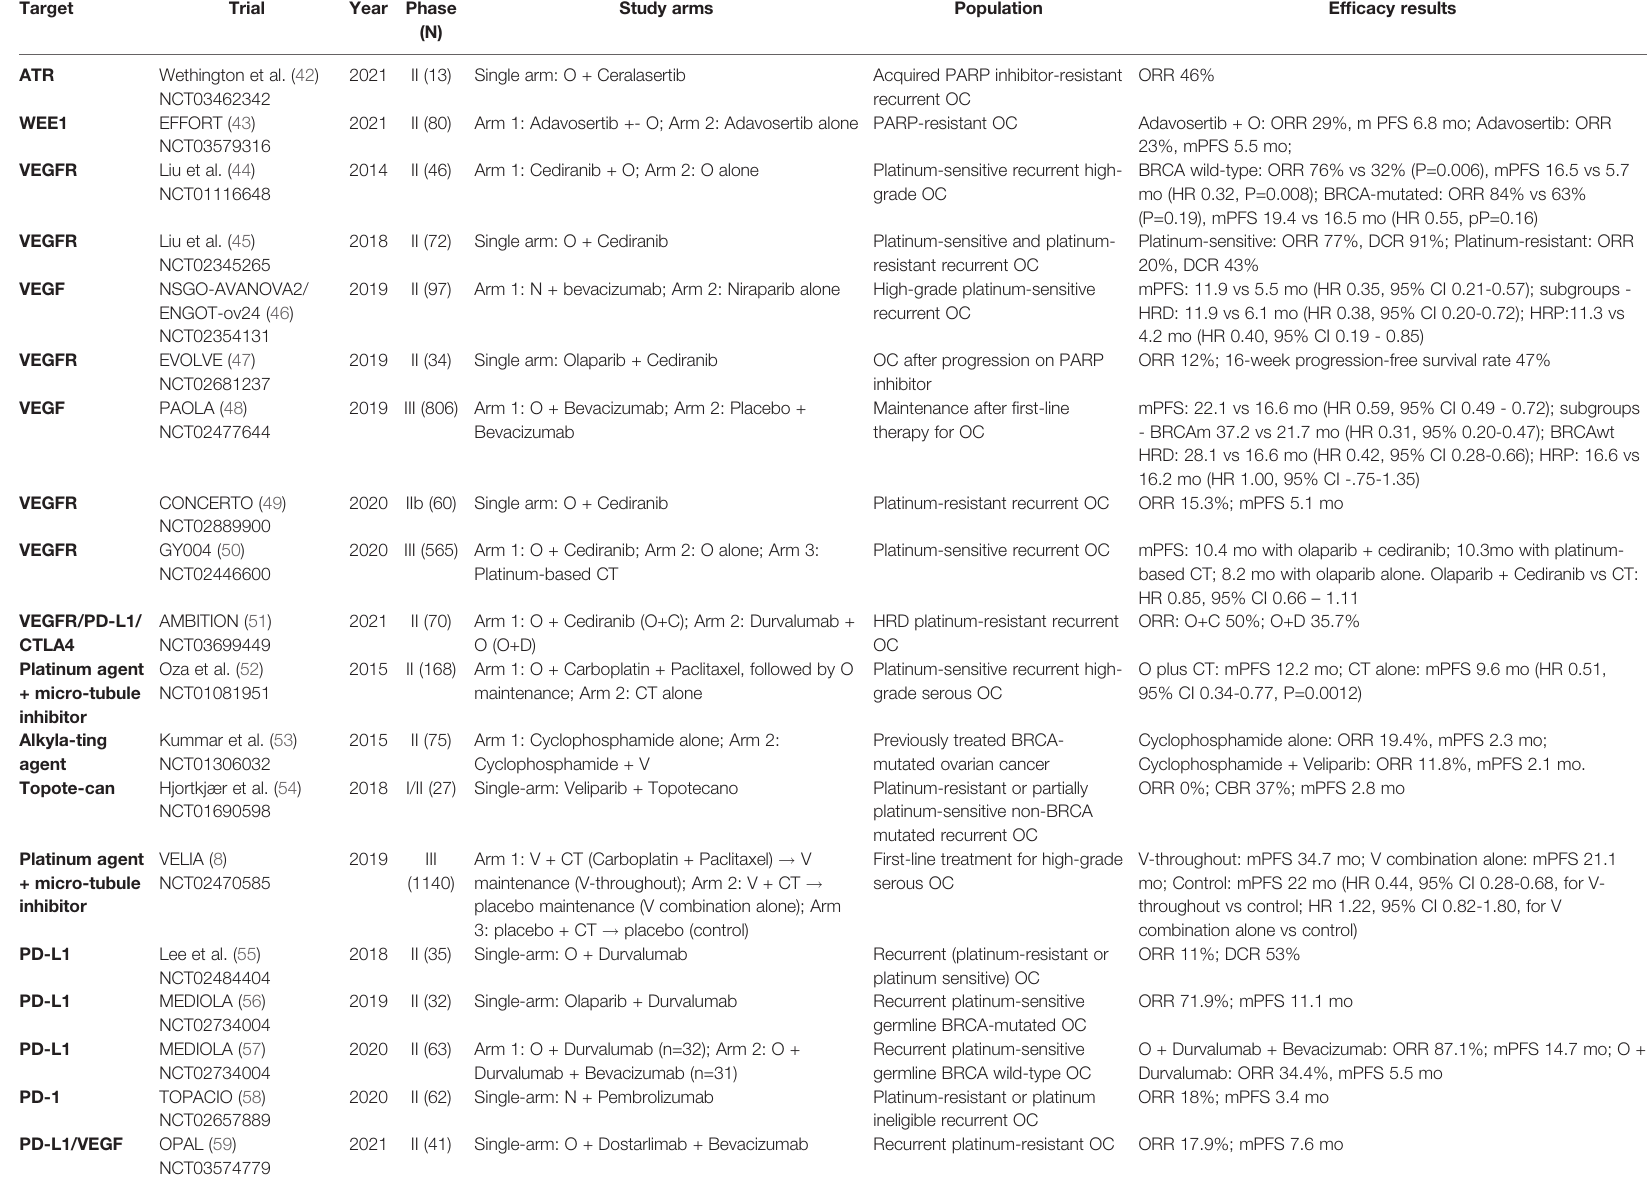
TABLE 1 | Published phase II-III studies of PARP inhibitor